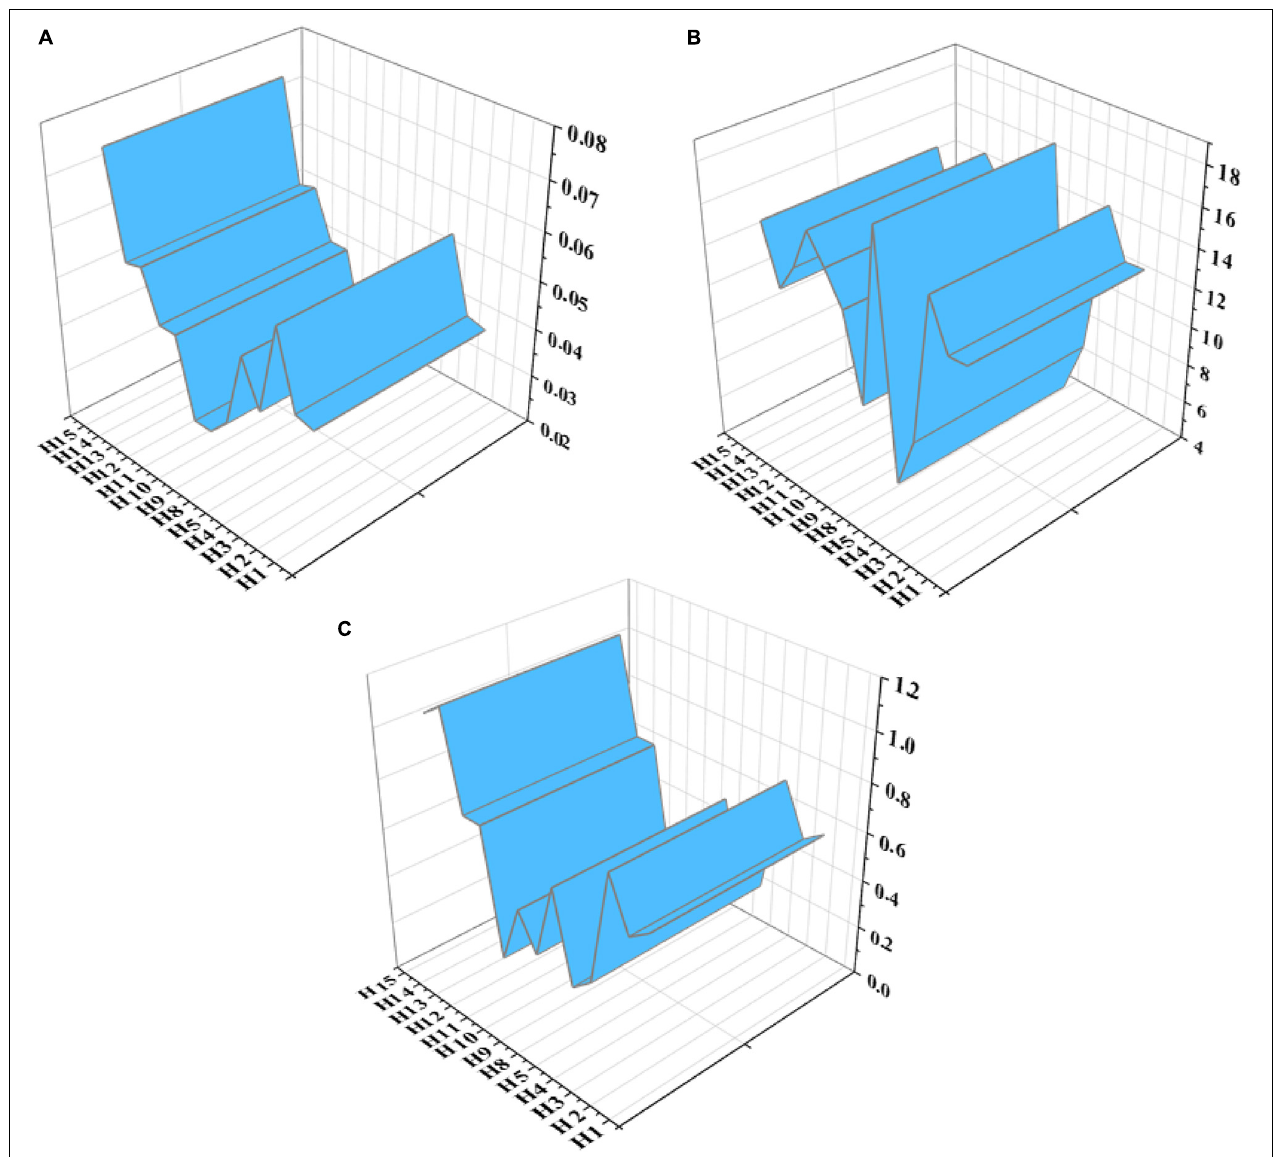
FIGURE 13 | Parameter test value of the modified structural model. (A) Test value of S.E. (B) Test value of C.R. (C) Test value of β